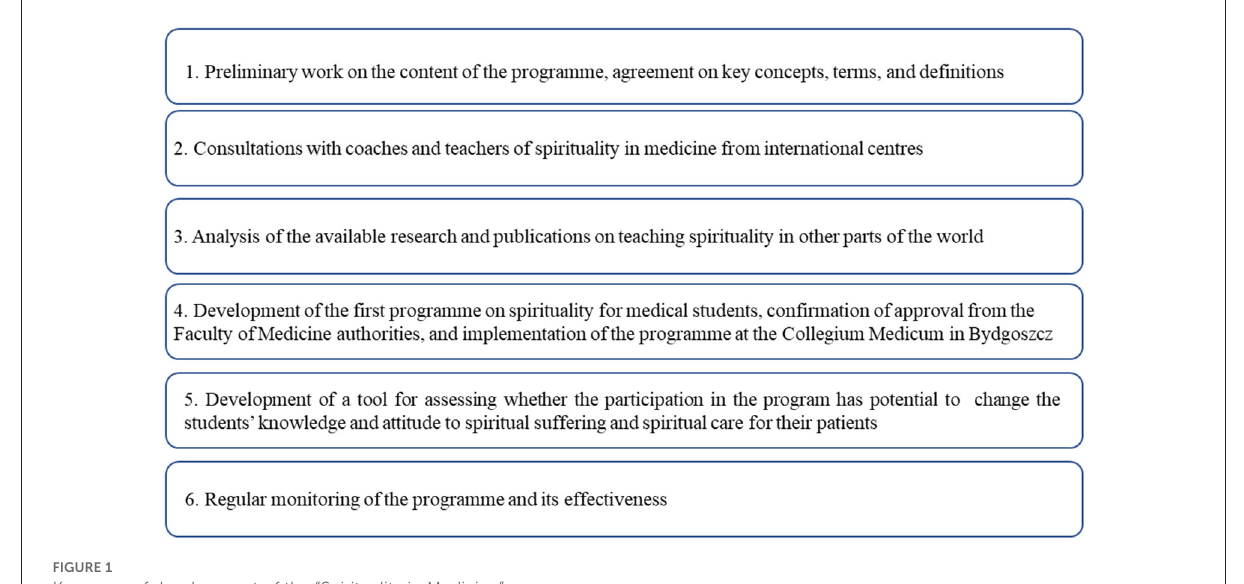
FIGURE1 Key areas of development of the “Spirituality in Medicine”